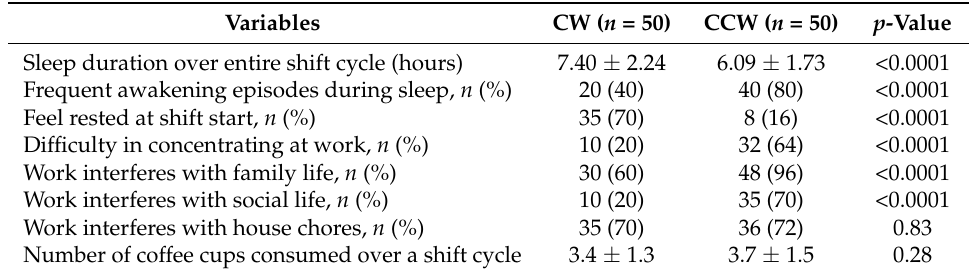
Table 2. Sleep duration, work performance, social and family life characteristics in the clockwise (CW) and counterclockwise (CCW) rotating groups.